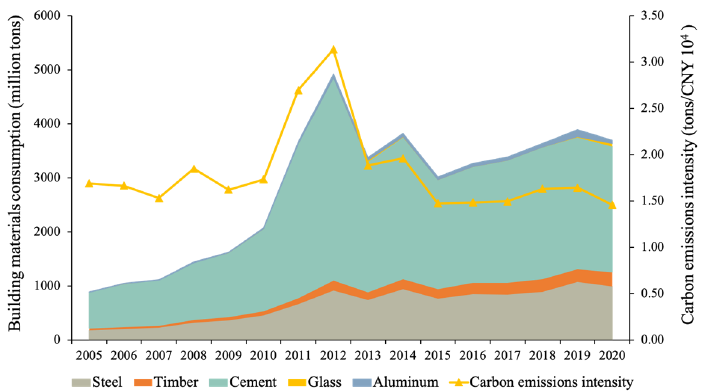
Figure 7. Consumption of building materials and its carbon emissions intensity in the building sec- tor.